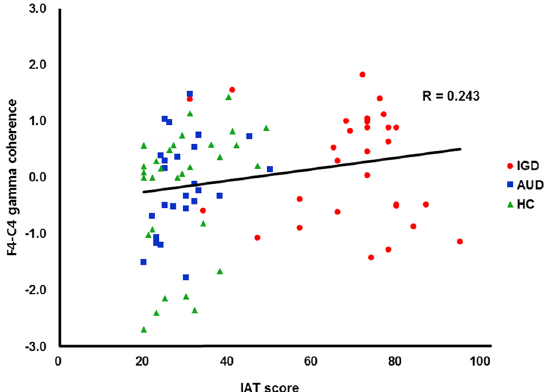
Figure 3. Correlation between the F4-C4 gamma coherence and the score on IAT. The scatter plot presents the correlation between variables in IGD (red circle), AUD (blue square), and HC (green triangle) groups. Fisher’s Z-transformed scores were used for the EEG data. 2000 sample bootstrapping was applied with Pearson’s correlation, and the significance level was set at 0.050. IGD = Internet gaming disorder; AUD = alcohol use disorder; HC = healthy control; EEG = electroencephalography.